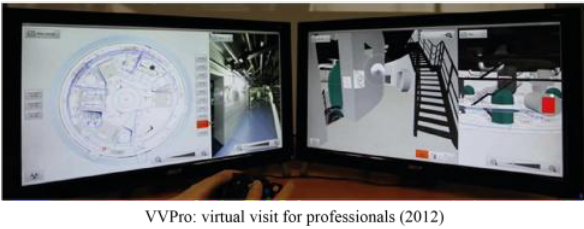
Figure 2: VVPro, offering for the user an experience similar to a bundle of Google Maps + Street + Earth, is one of the of virtual visit developed at EDF to fulfil increasing needs associated to maintenance operations. Multiple as-built data types are synced during the visit (maps, 3D models, panoramic